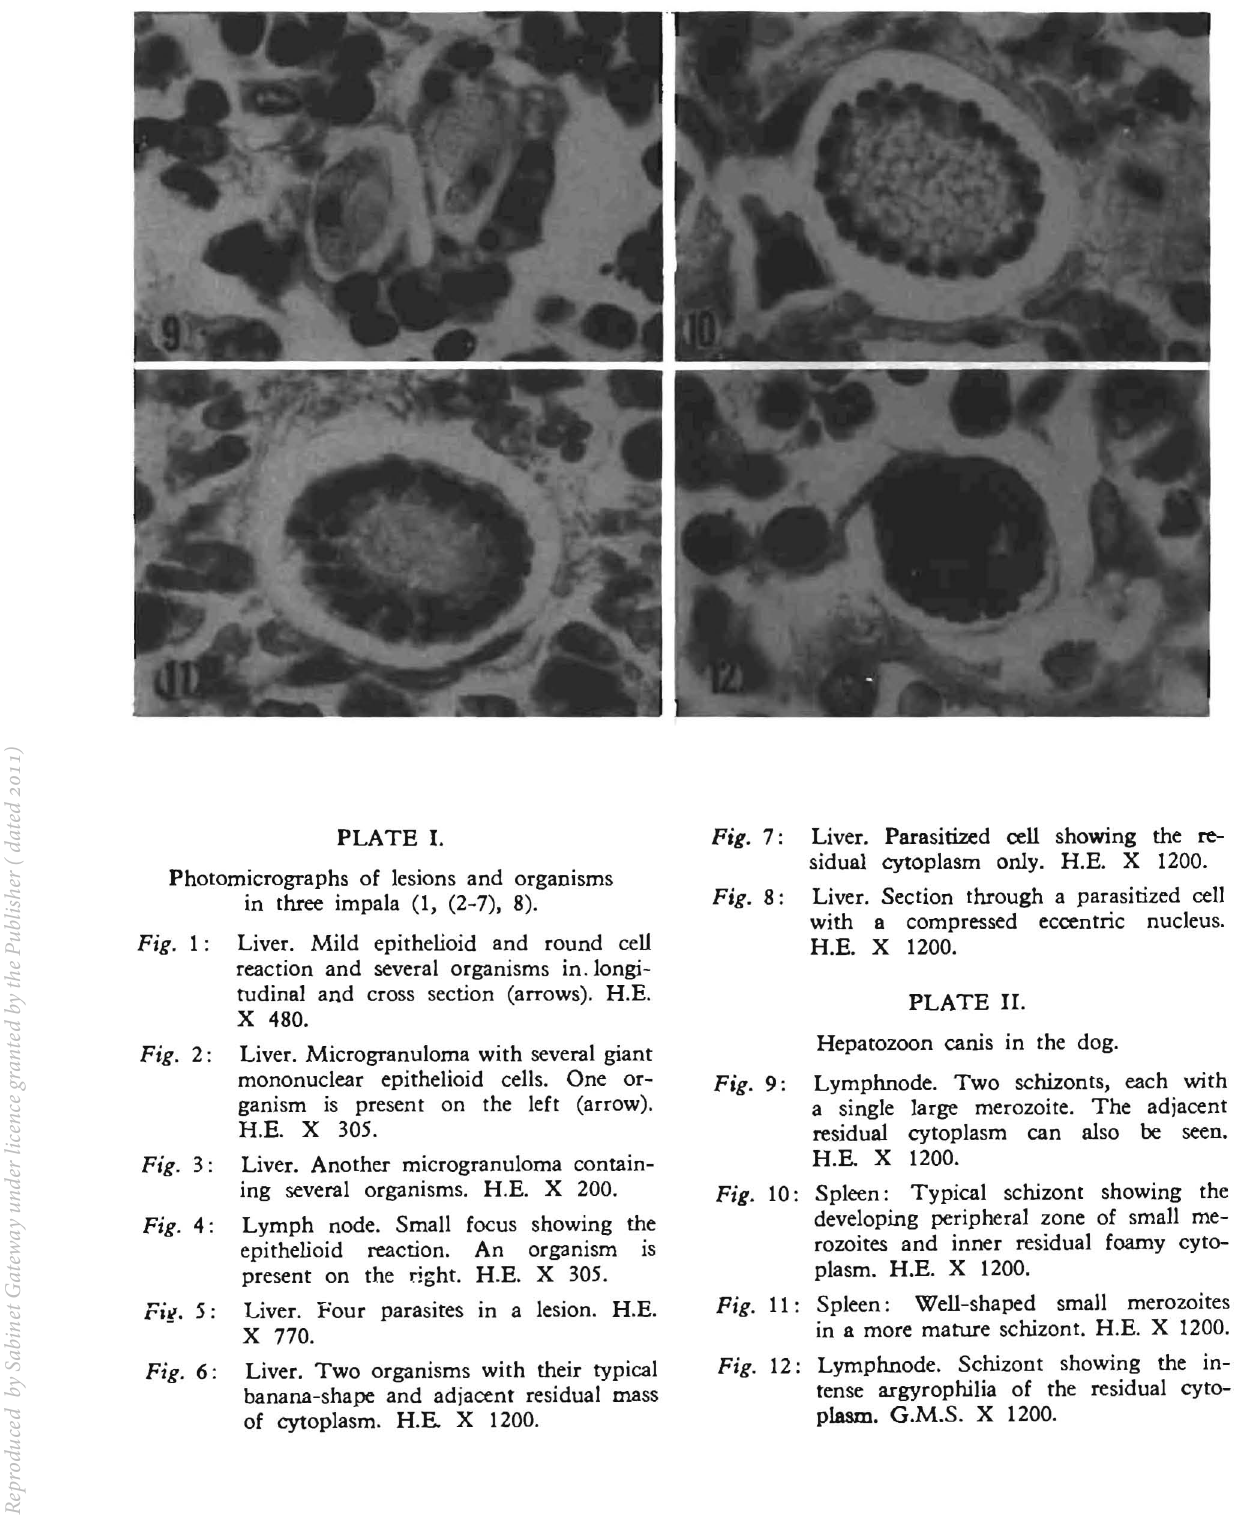
Fig. 7: Liver. Parasitized cell showing the re sidual cytoplasm only. H.E. X 1200. Fig. 8: Liver. Section through a parasitized cell with a compressed eccentric nucleus. H.E. X 1200. PLATE II. Hepatozoon canis in the dog. Fig. 9: Lymphnode. Two schizonts, each with a single large merozoite. The adjacent residual cytoplasm can also be seen. H.E. X 1200. Fig. 10: Spleen: Typical schizont showing the developing peripheral zone of small me rozoites and inner residual foamy cyto plasm. H.E. X 1200. Fig. 11: Spleen: Well-shaped small merozoites in a more mature schizont. H.E. X 1200. Fig. 12: Lymphnode. Schizont showing the in tense argyrophilia of the residual cyto plasm. G.M.S. X